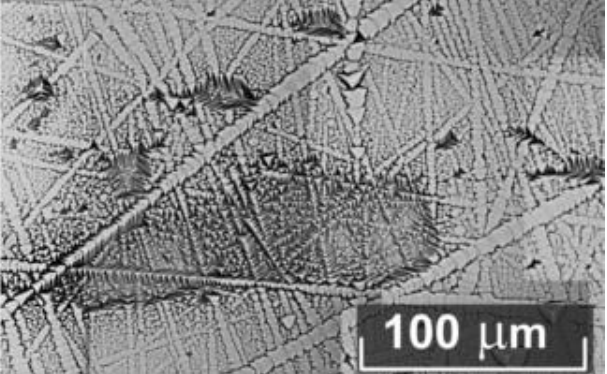
Figure 11. The separation of the second phase, connected to the crystal matrix by semi-coherent boundaries in an LiNbO 3 :Zn ([ZnO] ≈ 6.52 mol.% in the melt) crystal. Z-cut.